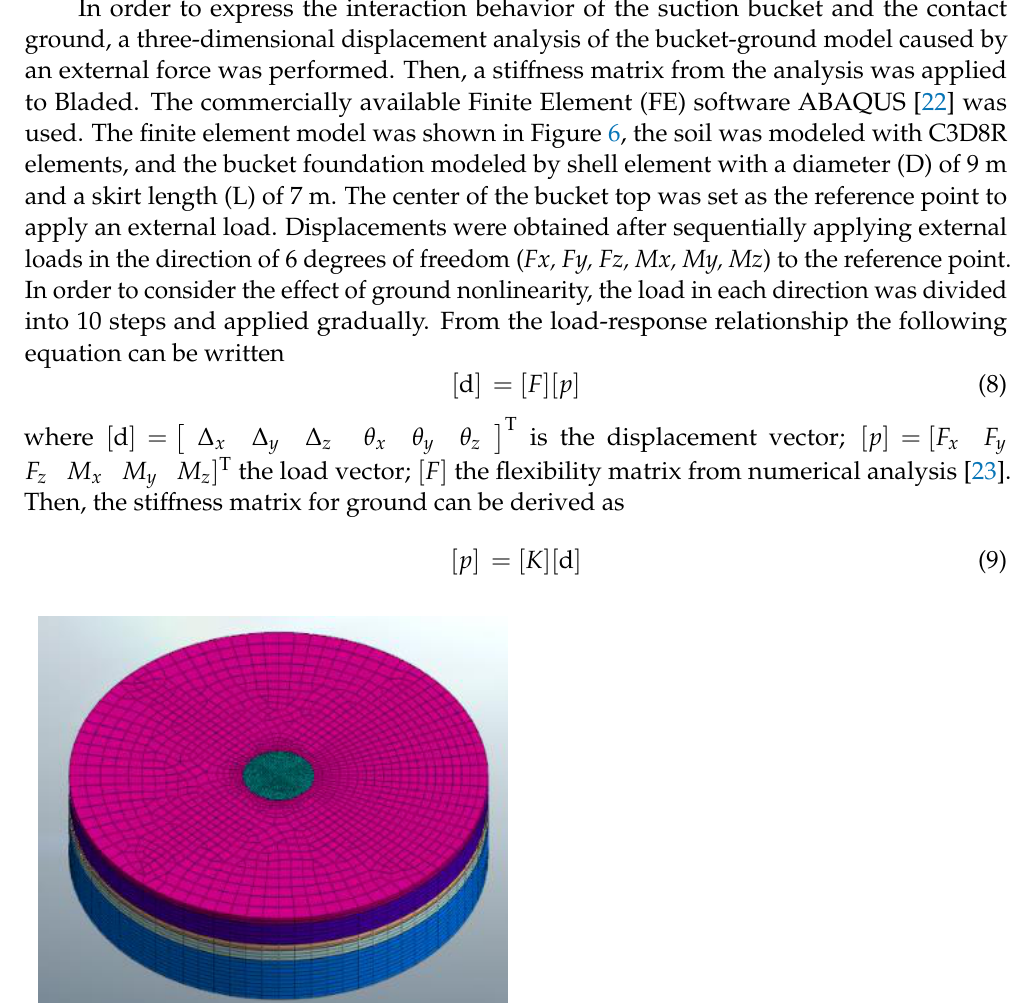
Figure 7. Bladed input for stiffness of foundation spring. 4.3. Wind Thrust Thrust force by wind is automatically calculated in Bladed. At first, a wind field was generated using the Kaimal model, and a total of 30 cases of thrust force set was calculated by changing the phase of the wind field. Figure 8 shows a time history of thrust force for 10 min calculated by Bladed.